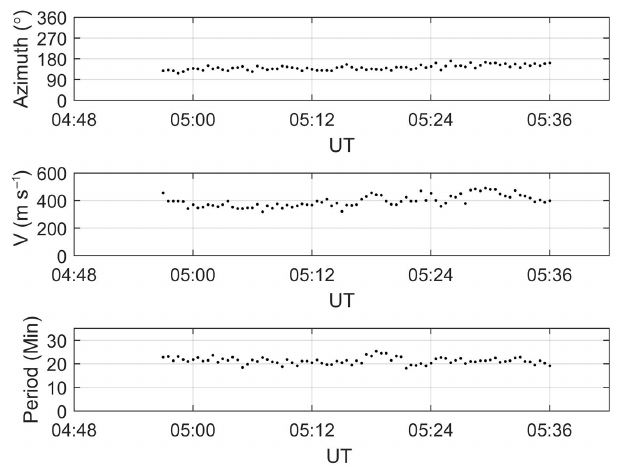
Figure 4. Temporal variations of propagation azimuth (clockwise from north, panel a ), horizontal phase velocity (panel b ), and pe- riod (panel c ) for the traveling ionospheric disturbance observed on 15 February 2013 over northwest China. Temporal variations of the parameters were obtained by applying multi-channel maximum en- tropy method to the TEC time series observed by three Chinese GPS stations whose locations are marked as blue dots in Fig. 1.